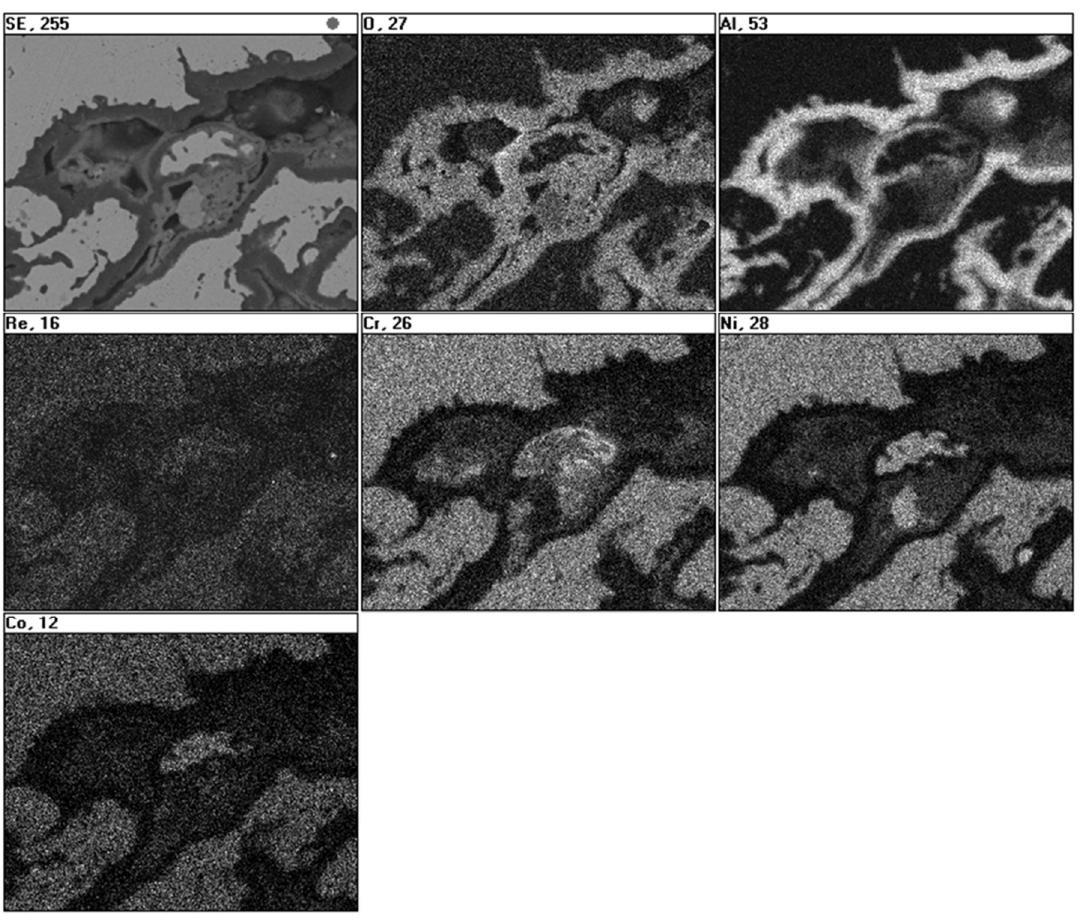
Figure 5. EDS maps showing the distribution of the elements in the oxidized region shown in Figure 4. Dark grey alumina scale grows at splat boundary and is somewhere supported by irregular grey mixed